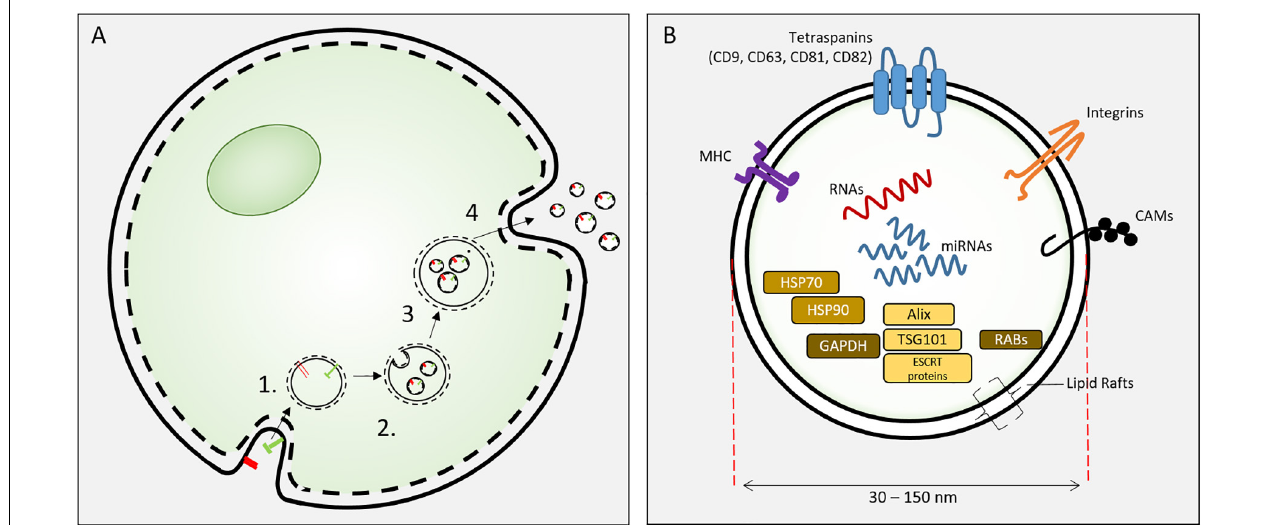
FIGURE 2 | (A) Exososome biosynthesis. Exosomes are formed from endosomes (1) by an inward budding process to form intracellular vesicles (2). These mature as multivesicular bodies (3) that fuse with the cell plasma membrane to release exosomes. (B) Exosomes are 30–150 nm extracellular vesicles containing specific proteins, RNAs and lipids. Proteins include HSP70, 90, GAPDH; proteins involved in synthesis (Alix, ESCRT proteins, TGS101), and membrane associated or transmembrane proteins (RABs, Annexins, CAMs, Integrins, Tetraspanins, MHC I and II) and other cytosolic